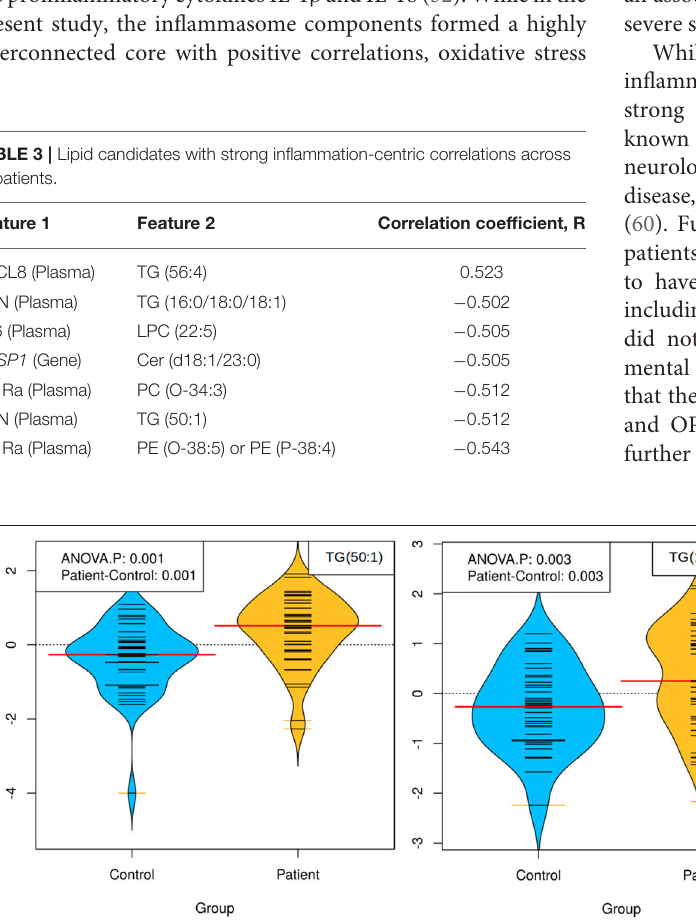
Frontiers in Psychiatry |